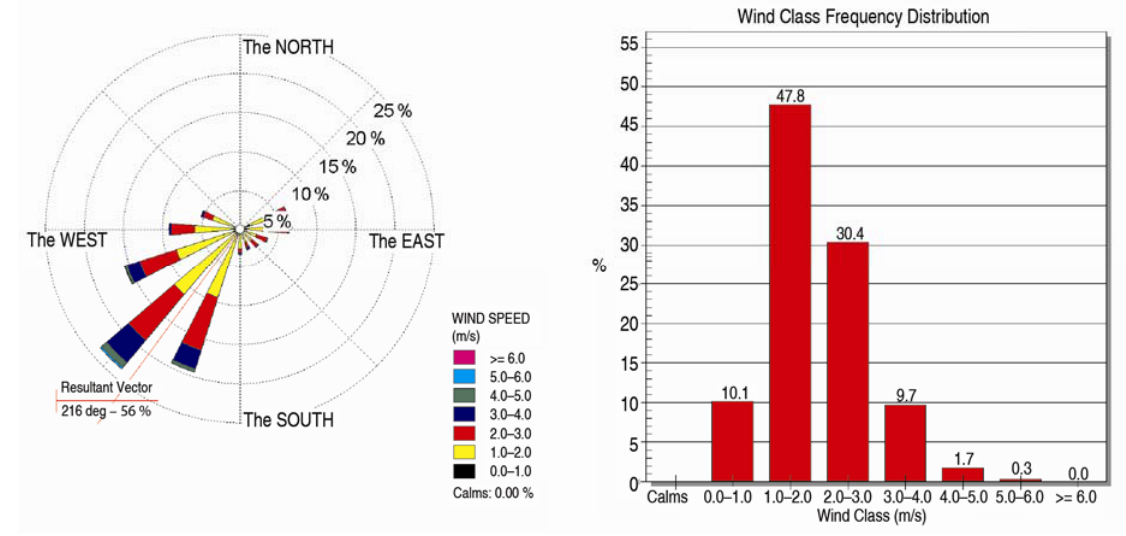
Fig 3 . Relationship between wind speed and direction and frequency distribution of wind speed during June–October of